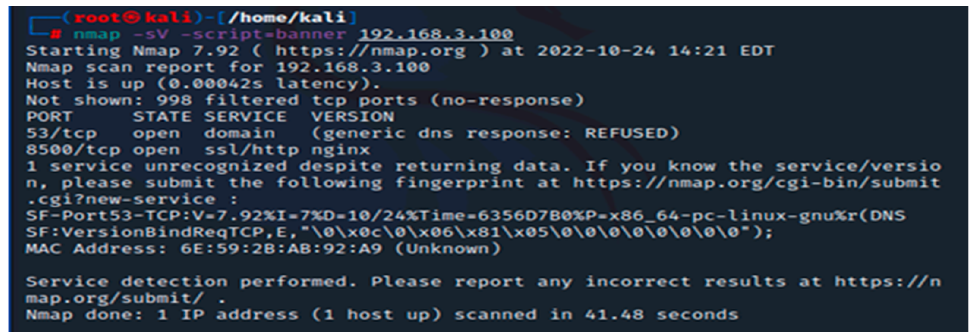
Figure 6. Netcat Banner Grabbing.